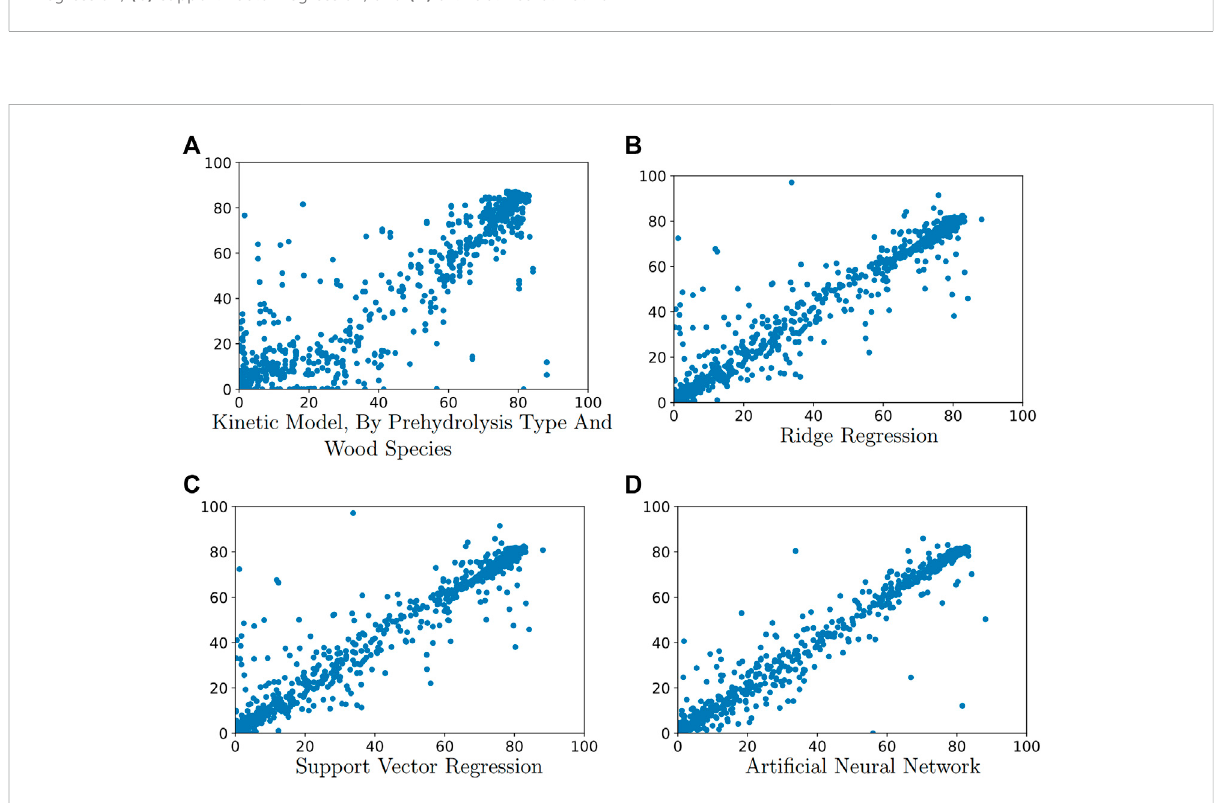
FIGURE 2 Predicted versus actual yield of monomeric xylose for test data for: (A) kinetic model fi t by prehydrolysis type and wood species, (B) ridge regression, (C) support vector regression, and (D) arti fi cial neural